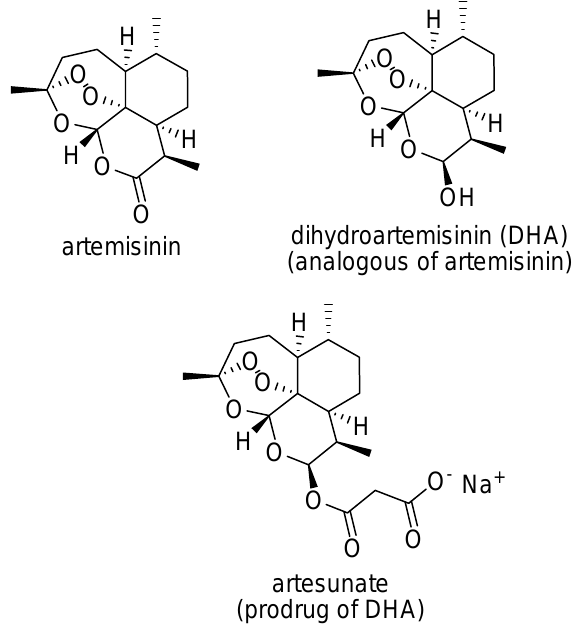
Figure 17. Chemical structures of artemisinin, dihydroartemisinin and artesunate sodium salt.